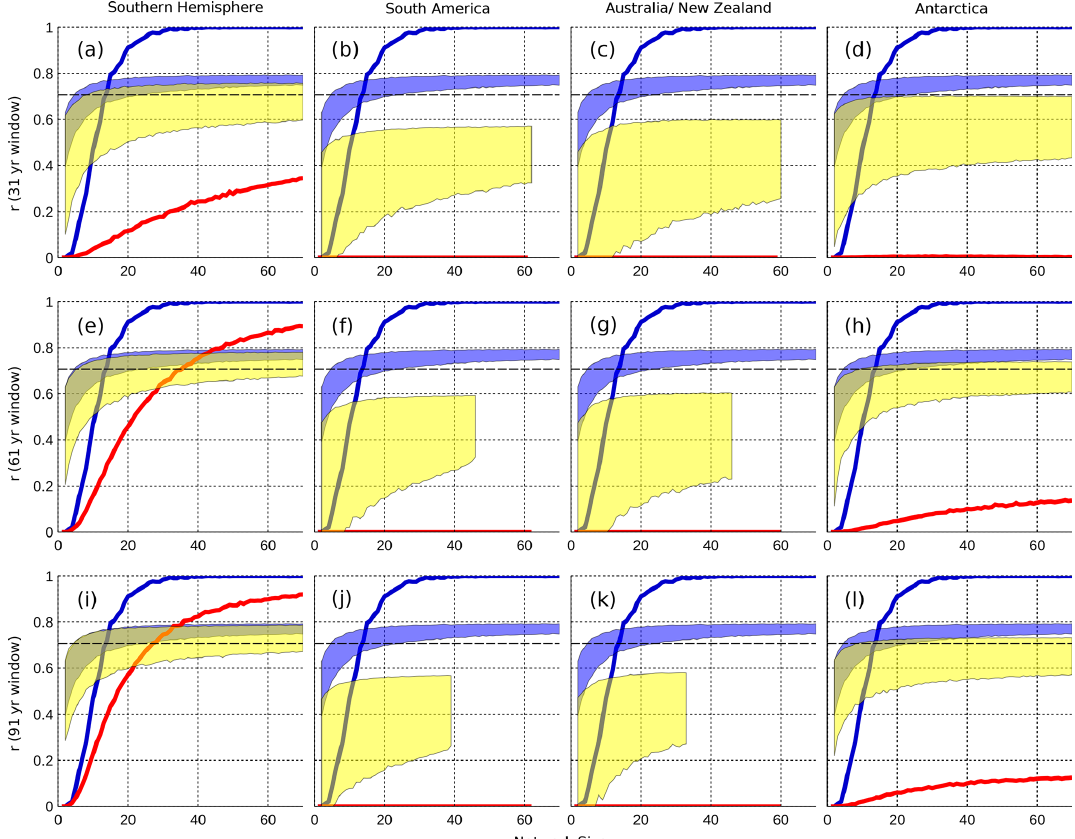
Figure 5. Differing reconstruction skill achieved when using precipitation-derived proxies sourced from the entire Southern Hemisphere (a, e, i) , South America (b, f, j) , Australia and New Zealand (c, g, k) , and Antarctica (d, h, l) only. The correlation between a precipitation- derived reconstruction and the SAM is plotted on the y axis, while the number of sites used ( n = 2 : 70) in a reconstruction is plotted on the x axis. Shaded regions represent the range between the minimum of the 5th percentile and the maximum of the 95th percentile for each network size across 10000 reconstructions (described in Sect. 2.3). Each set of regional reconstructions is shaded in yellow, and the end of this yellow region indicates the number of samples available when it is below 70. Each panel also includes the range in skill for reconstructions with sites sourced from the entire Southern Hemisphere and calibrated with a “true” 500 year window (blue shading). The blue line indicates the percentage of true SH reconstructions that meet or exceed our skill threshold of being able to explain 50% or more of the variability in the SAM. The red line indicates the same thing, but for each regional reconstruction. The dashed black line indicates the r value required to meet our skill